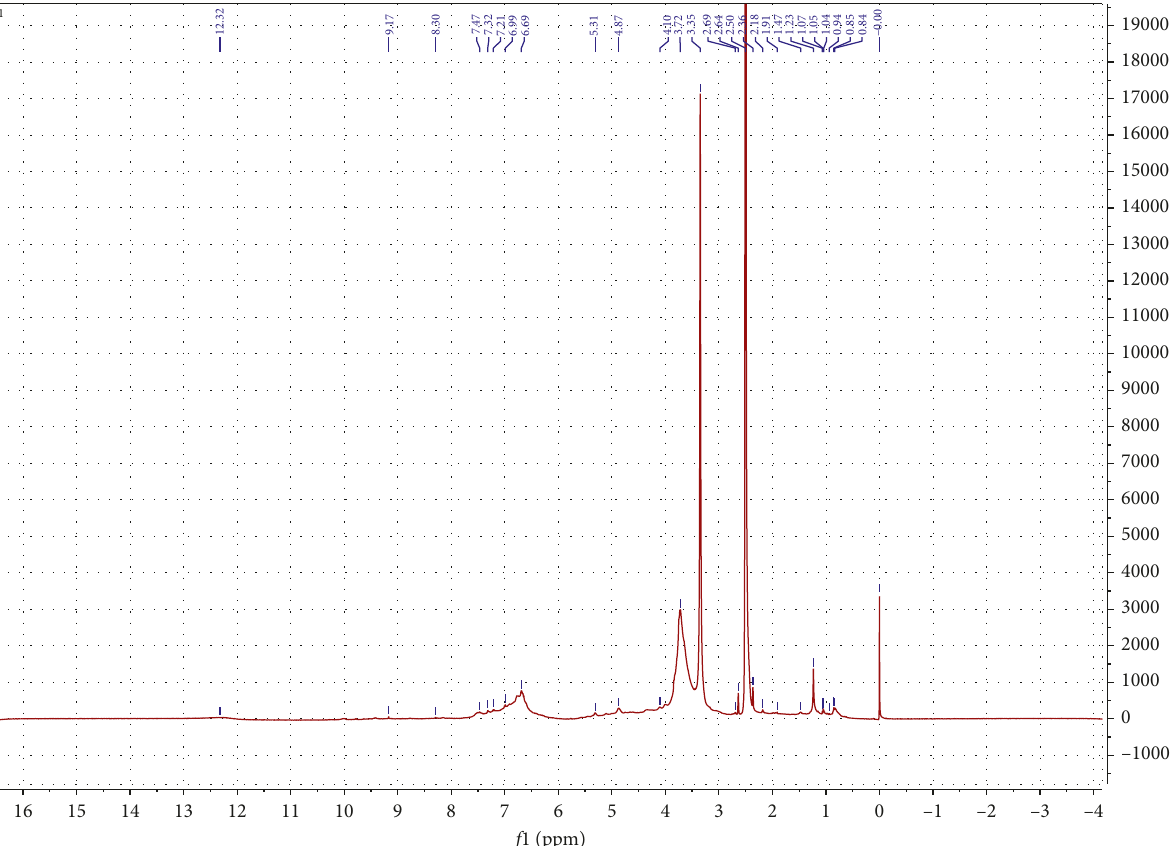
Figure 5: 1 H-NMR spectrum of acid-precipitated